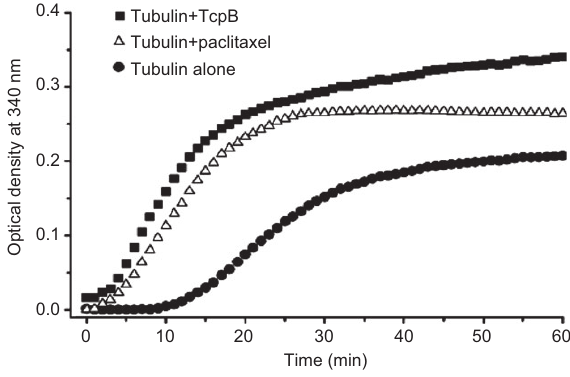
Figure 4 TcpB enhances the rate of microtubule polymerization like paclitaxel (Taxol). In vitro microtubule polymerization assay in the presence of purifi ed TcpB (0.5 mg/ml) or paclitaxel (5 µ m ). TcpB could effi ciently enhance the nucleation and growth phases of micro- tubule polymerization and the total amount of microtubules polymer- ized similar to the microtubule stabilization drug paclitaxel. Adapted from ref. (87).